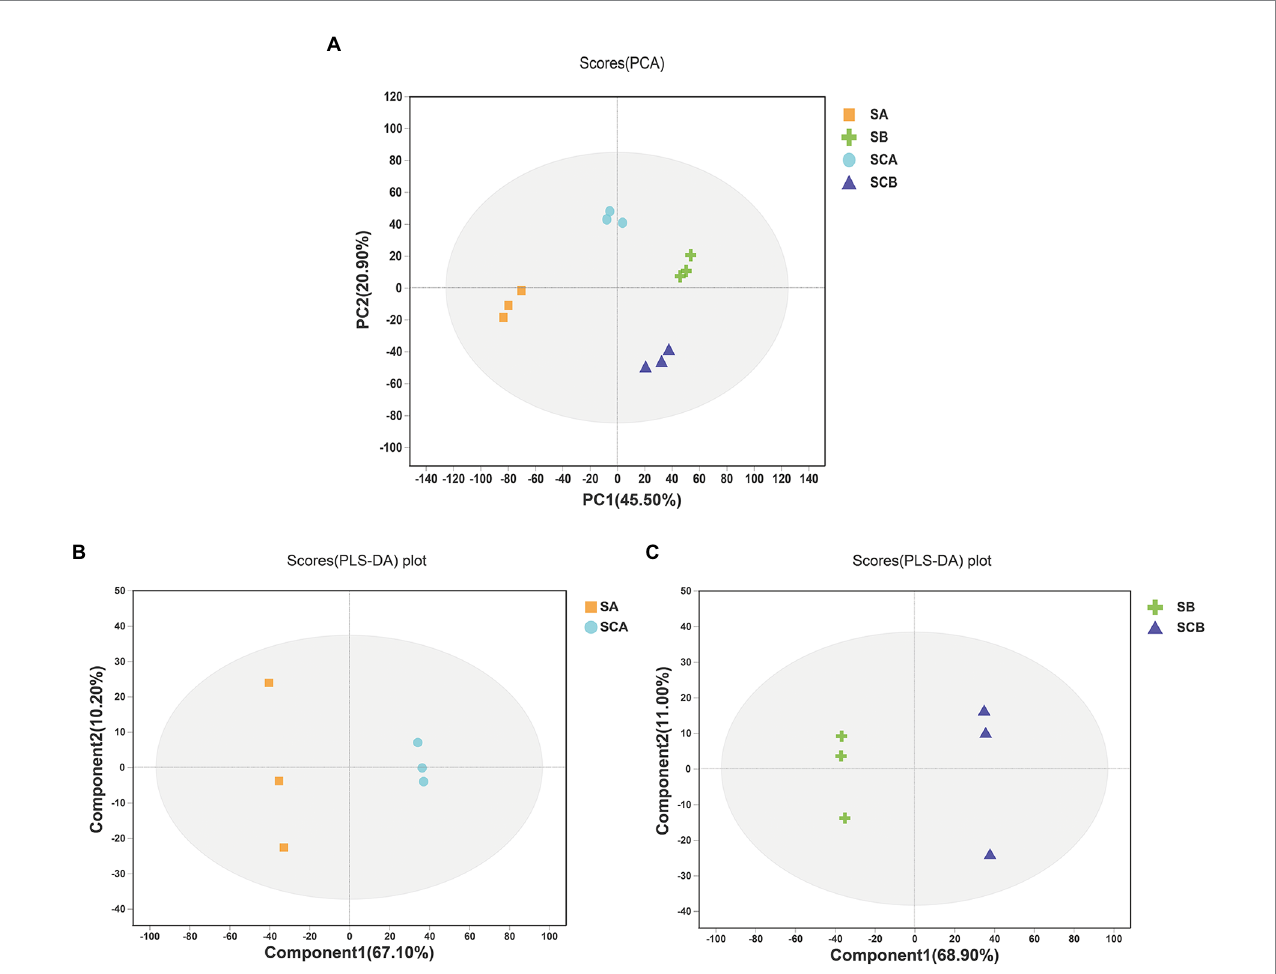
FIGURE 3 PCA score plots of intracellular metabolites (A) . PLS-DA score plots of intracellular metabolites between E. amstelodami pure culture and co-culture (B) . PLS-DA score plots of intracellular metabolites between B. licheniformis pure culture and co-culture (C) . (SA, intracellular metabolites of E. amstelodami pure culture; SCA, intracellular metabolites of E. amstelodami co-culture; SB, intracellular metabolites of B. licheniformis pure culture; SCB, intracellular metabolites of B. licheniformis